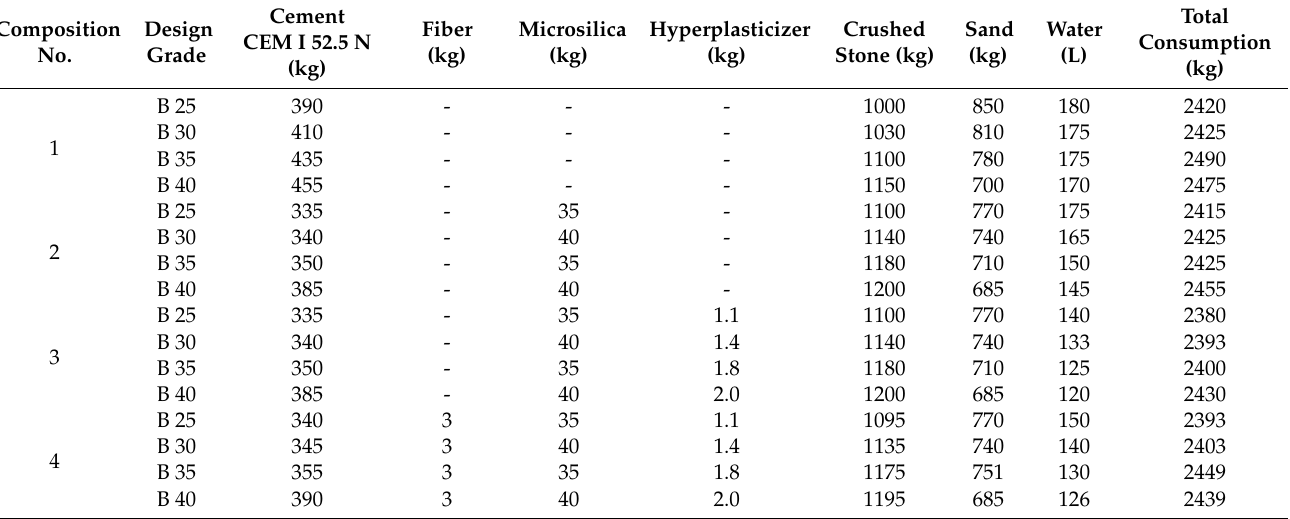
Table 3. Consumption of materials per 1 m 3 of concrete